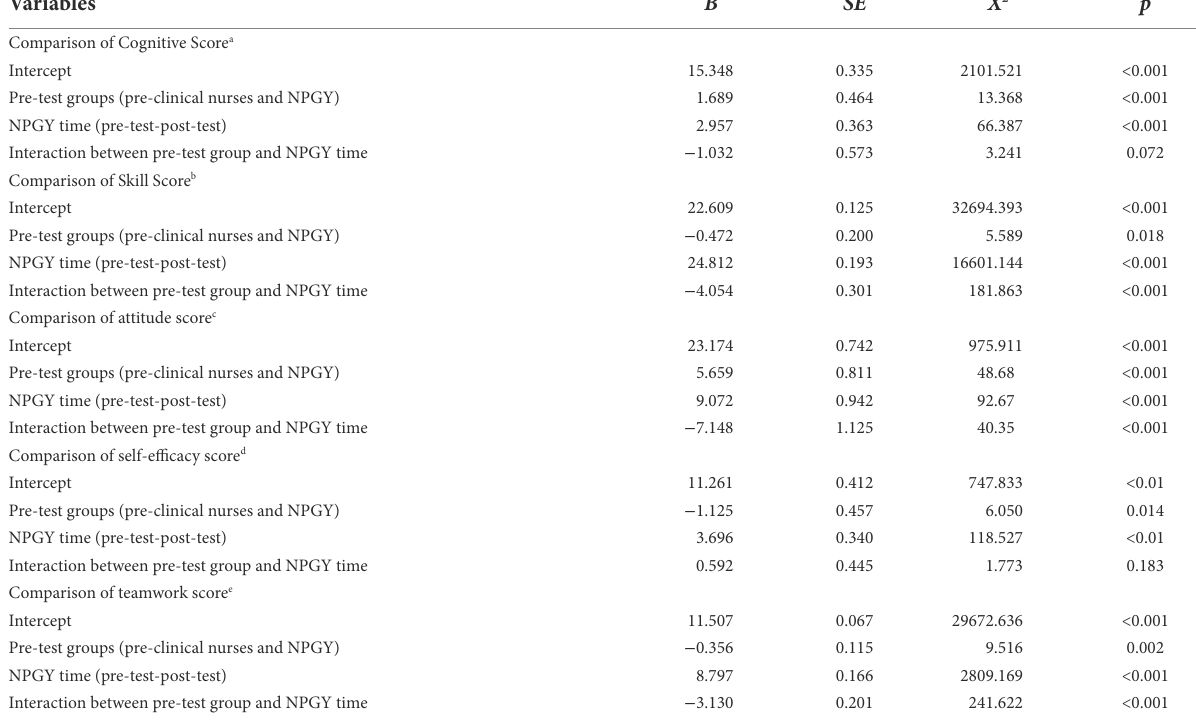
TABLE 3 GEE analysis of the difference in intervention effectiveness of the high-realistic situation simulation of dyspnea teaching program between the two groups. Variables B SE X 2